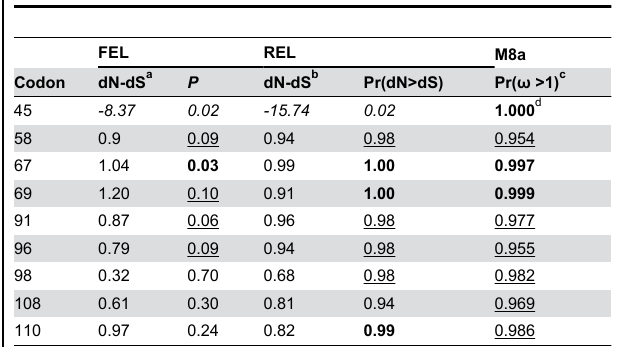
Table 2. Positive selection on codons among PrAvh205 orthologs and paralogs, for the nonrecombinant region from site 130 to 330.